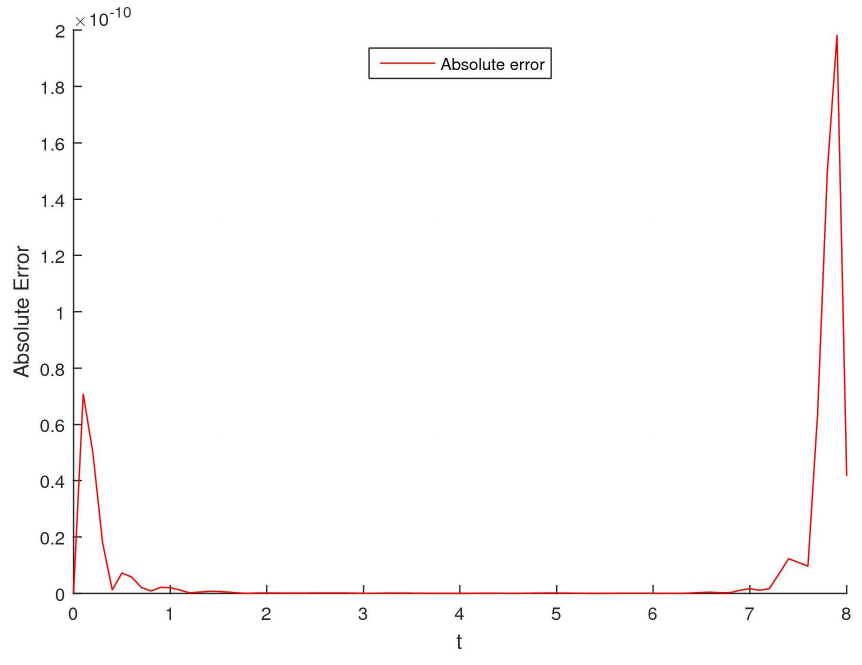
Figure 21. The absolute error of Example 6 for t ∈ [ 0,8 ] .